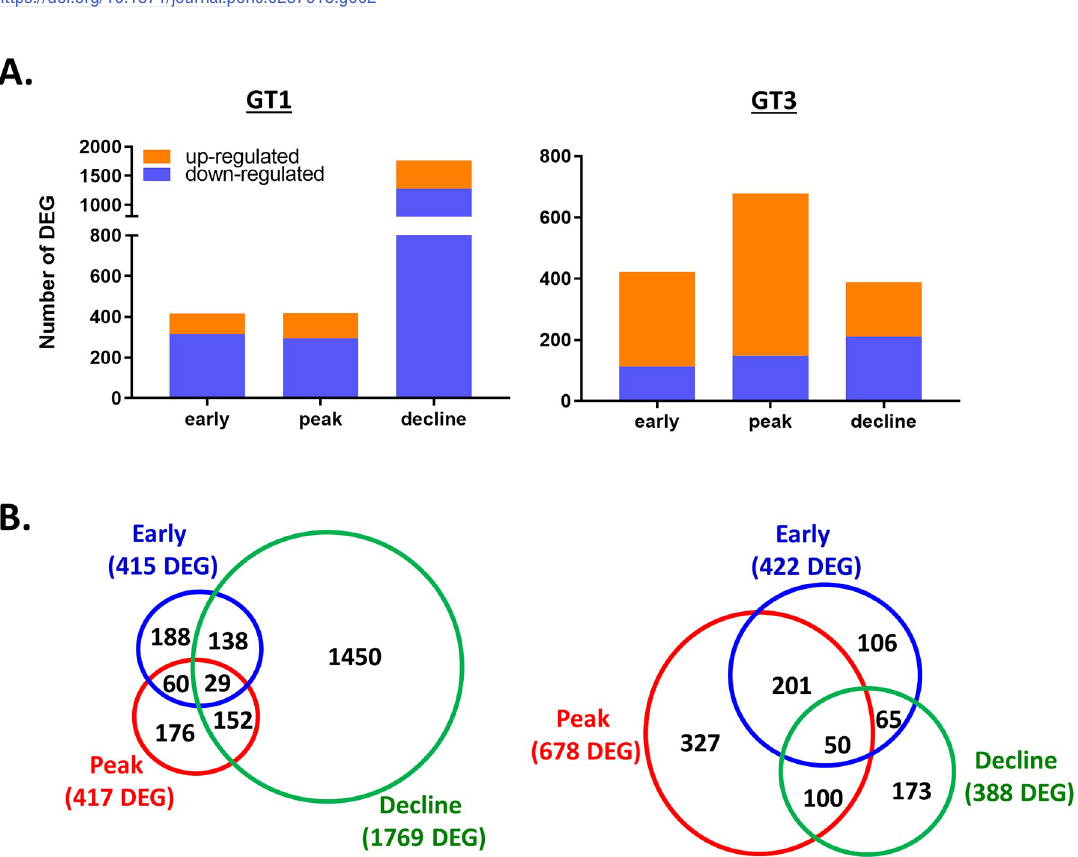
Fig 3. Analysis of differentially expressed genes during HEV gt1 and gt3 infections. (A), Bar chart of DEGs found to be upregulated or downregulated at early, peak, and decline phases during HEV gt1 and gt3 infections. (B), Venn diagram representing the number of DEGs between early, peak, and decline phases of HEV gt1 and gt3